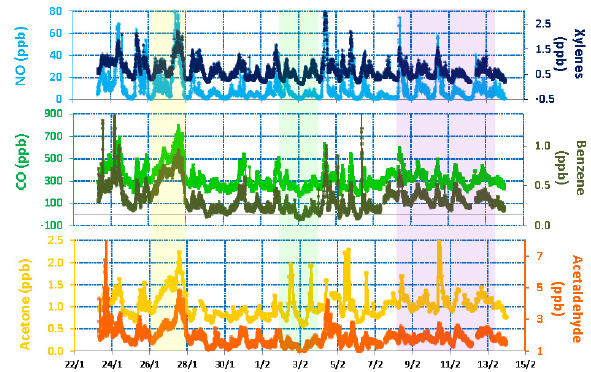
Fig. 7. Campaign time series: top panel: NO in light-blue solid line and the sum of xylenes in dark-blue solid line; 2nd panel: CO in light-green solid line and benzene in dark-green solid line; 3rd panel: acetone in light-orange solid line and acetaldehyde in dark- orange solid line. The three air mass periods are colored as follows: in yellow the Period I, in green, Period II, and in violet, Period